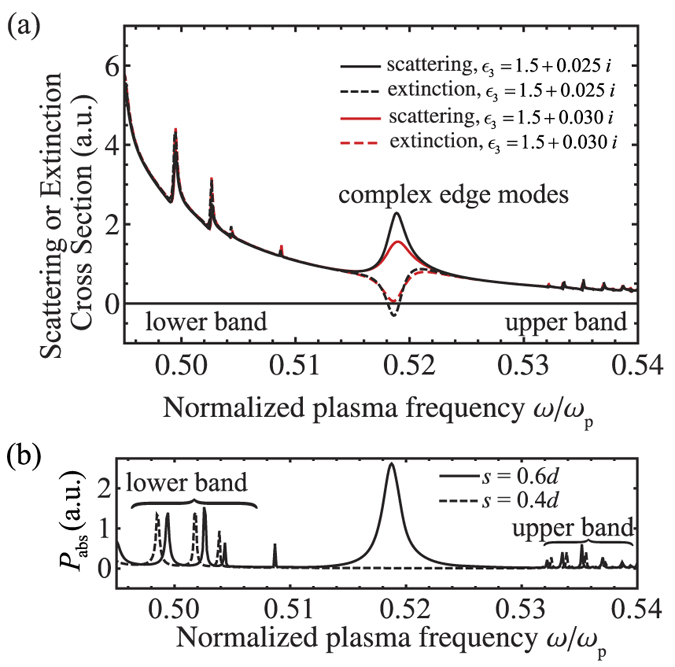
Verification by MST with the contribution from multipoles up to the 5th order.(a) Scattering and extinction cross sections of -symmetric particle arrays with ε3 = 1.5 + 0.025i and 1.5 + 0.03i (s = 0.6d). (b) Integrated field intensity Pabs of the mostly excited particle when ε3 = 1.5 + 0.025i, where Pabs is proportional to ω∫|E(r)|2d3r over the particle volume. The dashed peak in (b) at ω = 0.5188ωp indicated that the edge modes are strongly excited simultaneously. Other parameters are a = 0.125d, b = 0.175d, d = 100nm, N = 16, and 1/τ = 0.0001ωp.